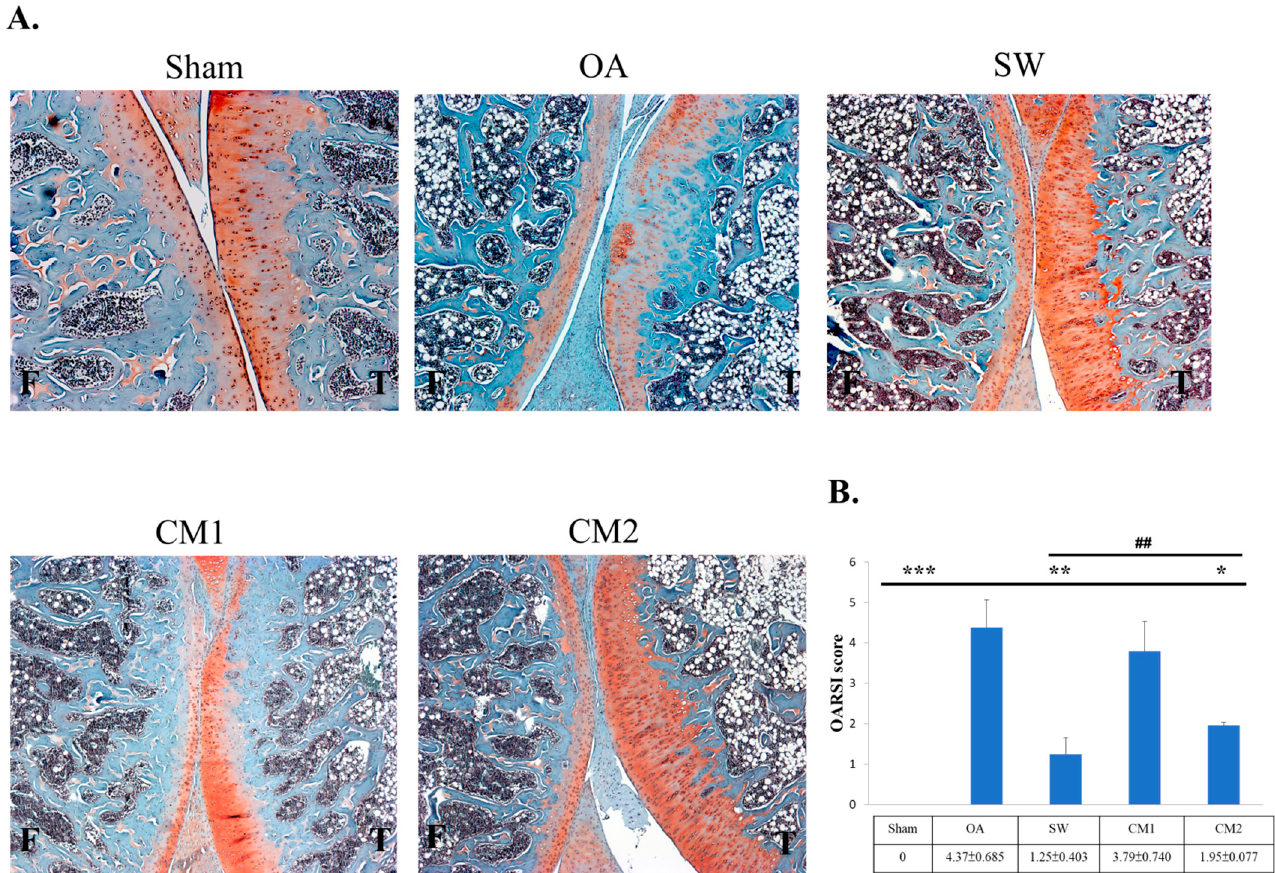
Figure 2. The pathological changes of the knee after shockwave (SW) and adipose-derived mesenchymal stem cells- conditioned medium (ADSC-CM) treatment. ( A ) The articular cartilage degradation of the knee in different groups (50 × magnification). The articular cartilage damage is evident in the OA group, and improvement was observed in SW, CM1, and CM2 groups. ( B ) The OARSI score in each group. * p < 0.05, ** p < 0.01 and *** p < 0.001 as comparing sham, SW, CM1, and CM2 groups with the OA group. ## p < 0.01 as comparing CM1 and CM2 groups with the SW group. The 100 and 200 µ L adipose-derived mesenchymal stem cells-conditioned medium treatments are indicated as CM1 and CM2, respectively. Eight rats were used for each group.